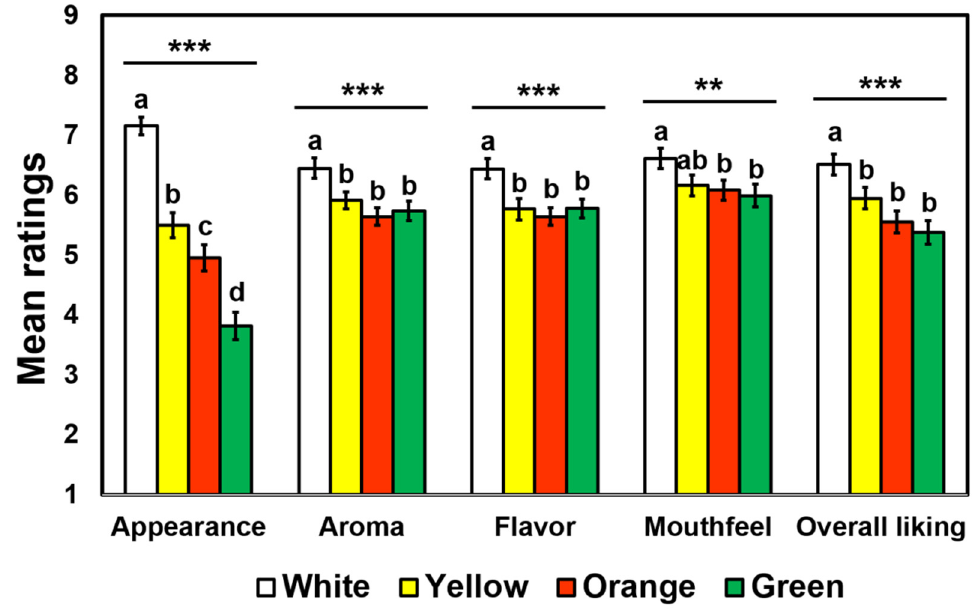
Figure 4. Mean rating comparisons among the four colored cooked-rice samples with respect to hedonic ratings of appearance, aroma, flavor, mouthfeel, and overall liking evaluated by 98 participants. Hedonic impressions of cooked-rice samples were evaluated on 9-point hedonic scales ranging from 1 (dislike extremely) to 9 (like extremely). Error bars represent standard errors of the means. ** and *** represent a significant di ff erence at p < 0.01 and p < 0.001, respectively. Mean ratings with di ff erent letters within a category indicate a significant di ff erence determined by post hoc multiple pairwise comparisons Tukey’s Honestly Significant Di ff erence (HSD) tests at p < 0.05.